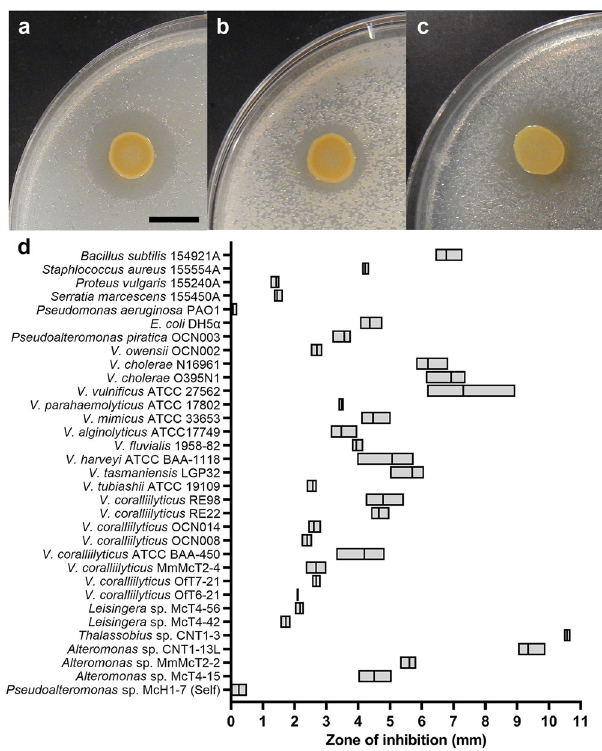
Fig. 1 Inhibitory activity of isolate McH1-7. Zone of inhibition (ZOI) of McH1-7 spotted onto target strains a Alteromonas sp. McT4-15, b Leisingera sp. McT4-56, or c Vibrio coralliilyticus OfT6-21. The black scale bar represents 10 mm. d Boxplot of ZOI measurements of the radius in mm of McH1-7 on different target strains. The boxes represent the range for three replicates and the middle line indicates the